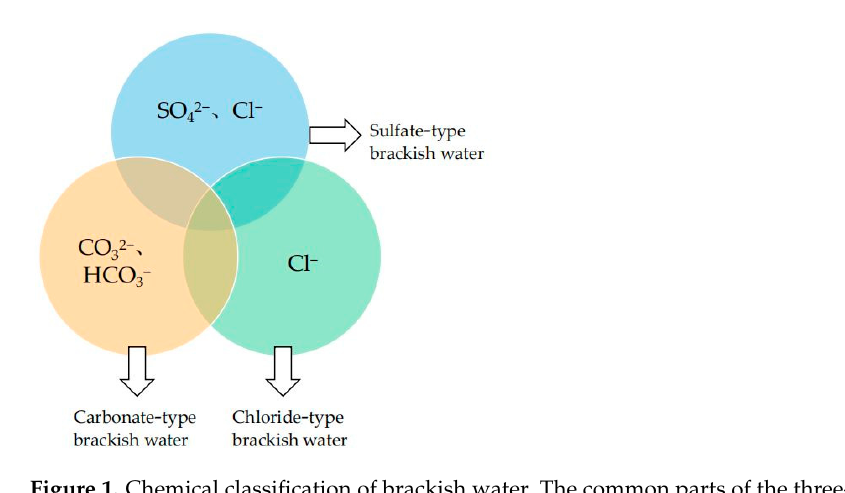
Figure 1. Chemical classification of brackish water. The common parts of the three-pie chart are K + , Na + , Ca 2+ and Mg 2+ , etc.